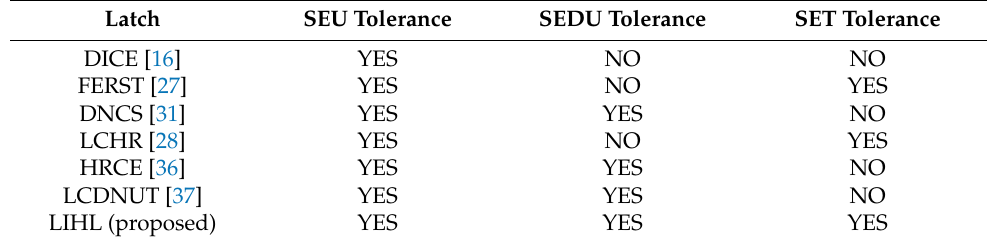
Table 1. Examples of Different Tolerance Storage